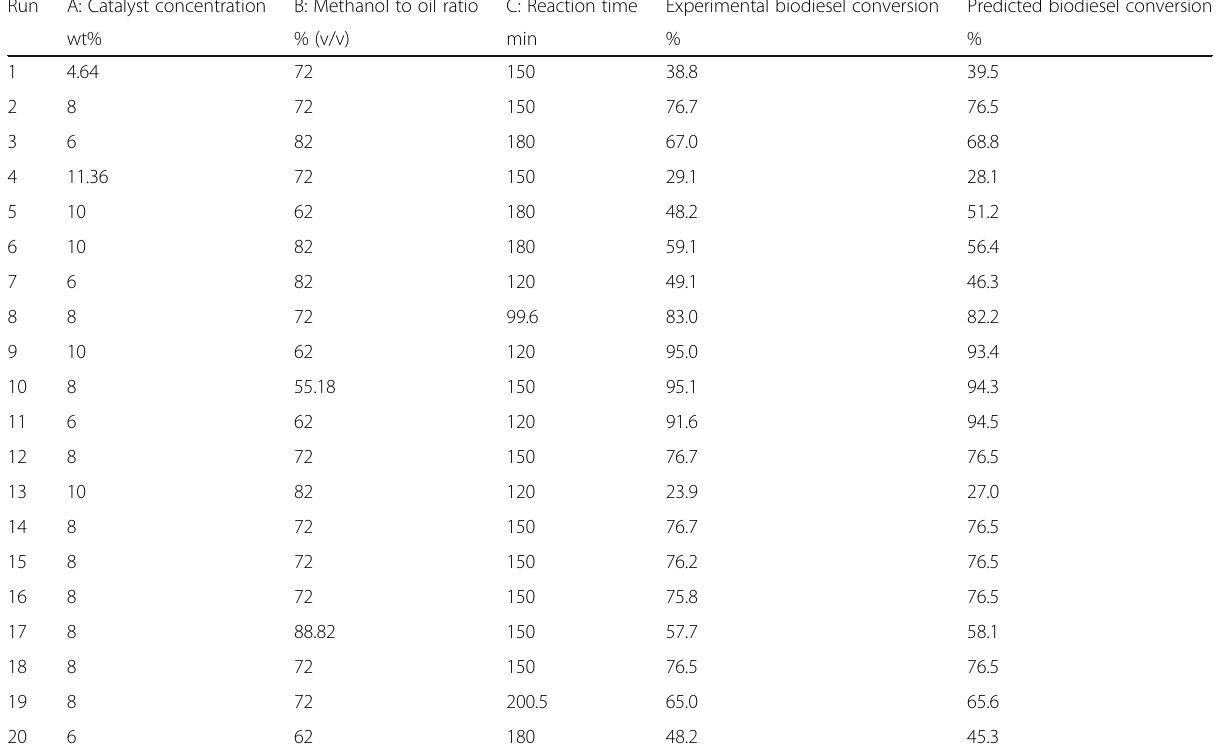
Table 4 CCD matrix for the biodiesel production from CIO-WCO mixture Run C: Reaction